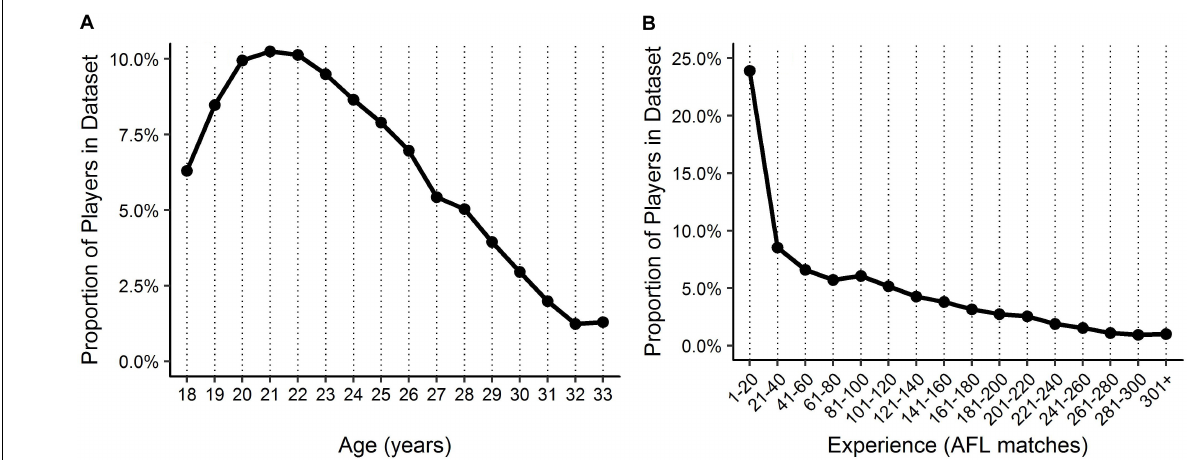
FIGURE 3 | Proportion of players in the dataset by (A) age and (B) experience.